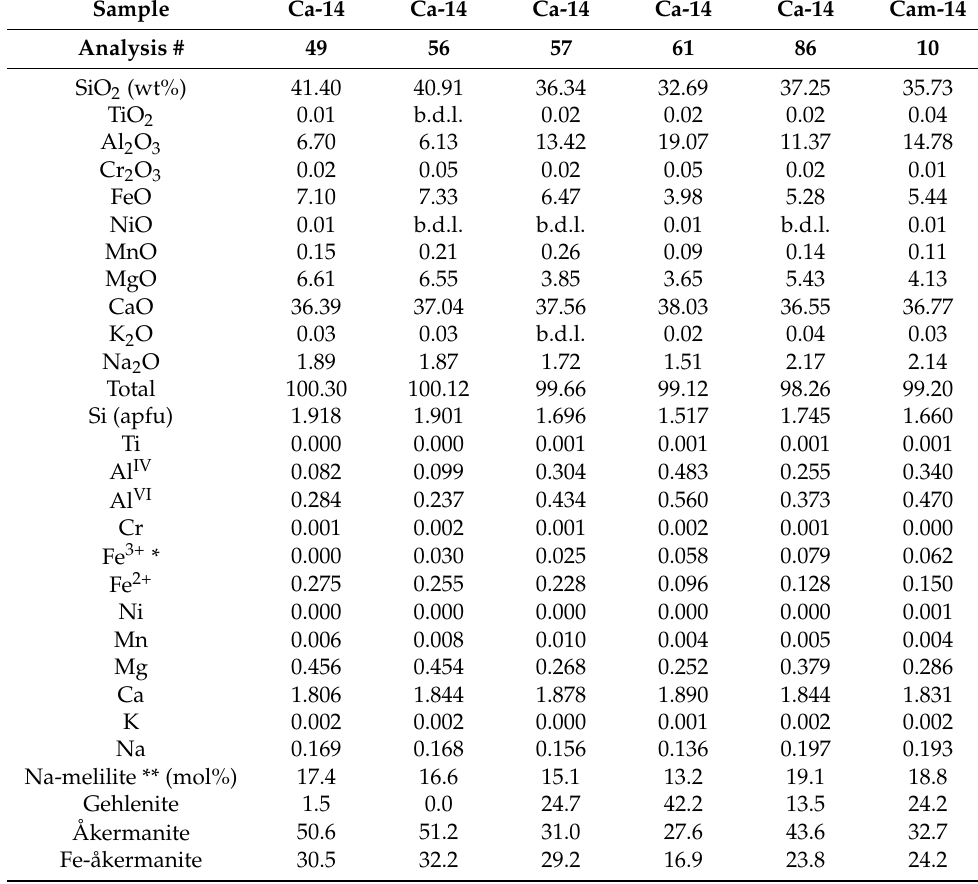
Table 3. Representative EPMA analyses, crystal chemistry and endmembers of melilite.